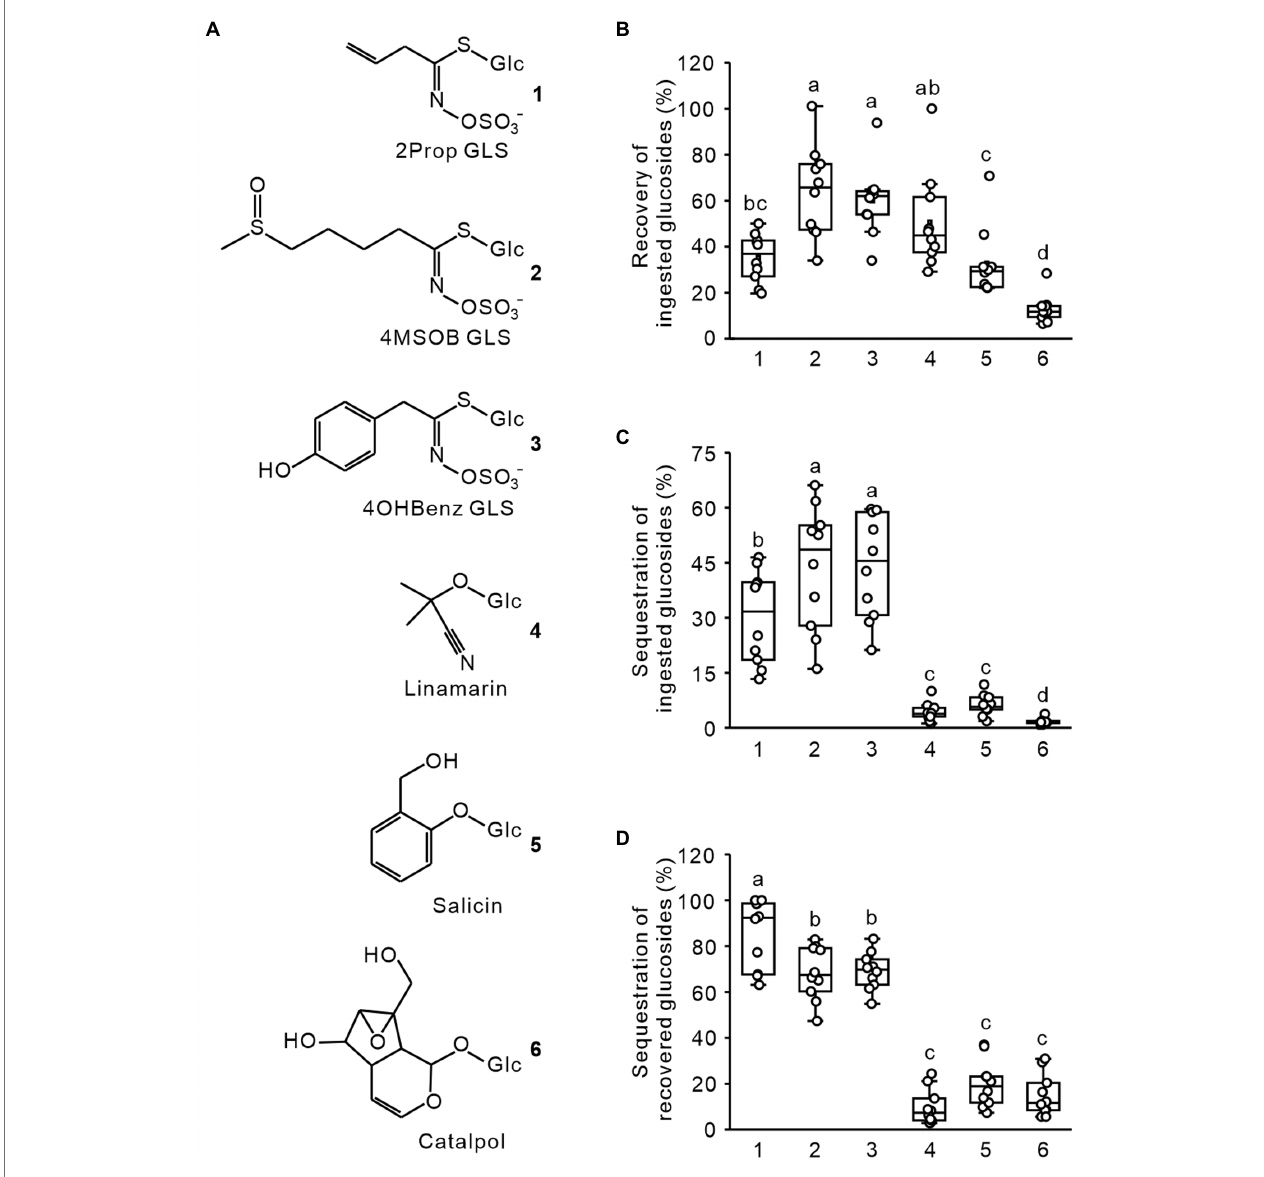
FIGURE 1 | Recovery and sequestration of ingested glucosides in adult Phyllotreta armoraciae . (A) Chemical structures of glucosinolates (GLS) and non-host glucosides used in feeding assays. (B) Recovery of ingested glucosides in P. armoraciae . Adult beetles were fed with 101.2 nl of an equimolar mixture of six glucosides. After 4 min, beetles were dissected into head, gut, and the remaining body. Tissues were extracted in 80% (v/v) methanol and the amounts of each glucoside were quantified using LC–MS/MS. To determine the recovery rate, we extracted 101.2 nl of the fed glucoside mixture and quantified the glucoside amounts with the same method. The total amounts of glucosides recovered in tissue extracts (head, gut, and remaining body combined) are expressed relative to the recovery control (set to 100%; n = 10). (C) The glucoside amount detected in the remaining body was expressed relative to the total ingested glucoside amount (set to 100%; n = 10). (D) The glucoside amount detected in the remaining body was expressed relative to the total amount detected in head, gut, and remaining body extracts (set to 100%; n = 10). Box plots show the median, interquartile range, and outliers of each dataset. Comparisons were conducted using generalized least squares method or one-way ANOVA. Boxplots labeled with different letters are significantly different ( p < 0.05). 2Prop, 2-propenyl; 4MSOB, 4-methylsulfinylbutyl; and 4OHBenz,